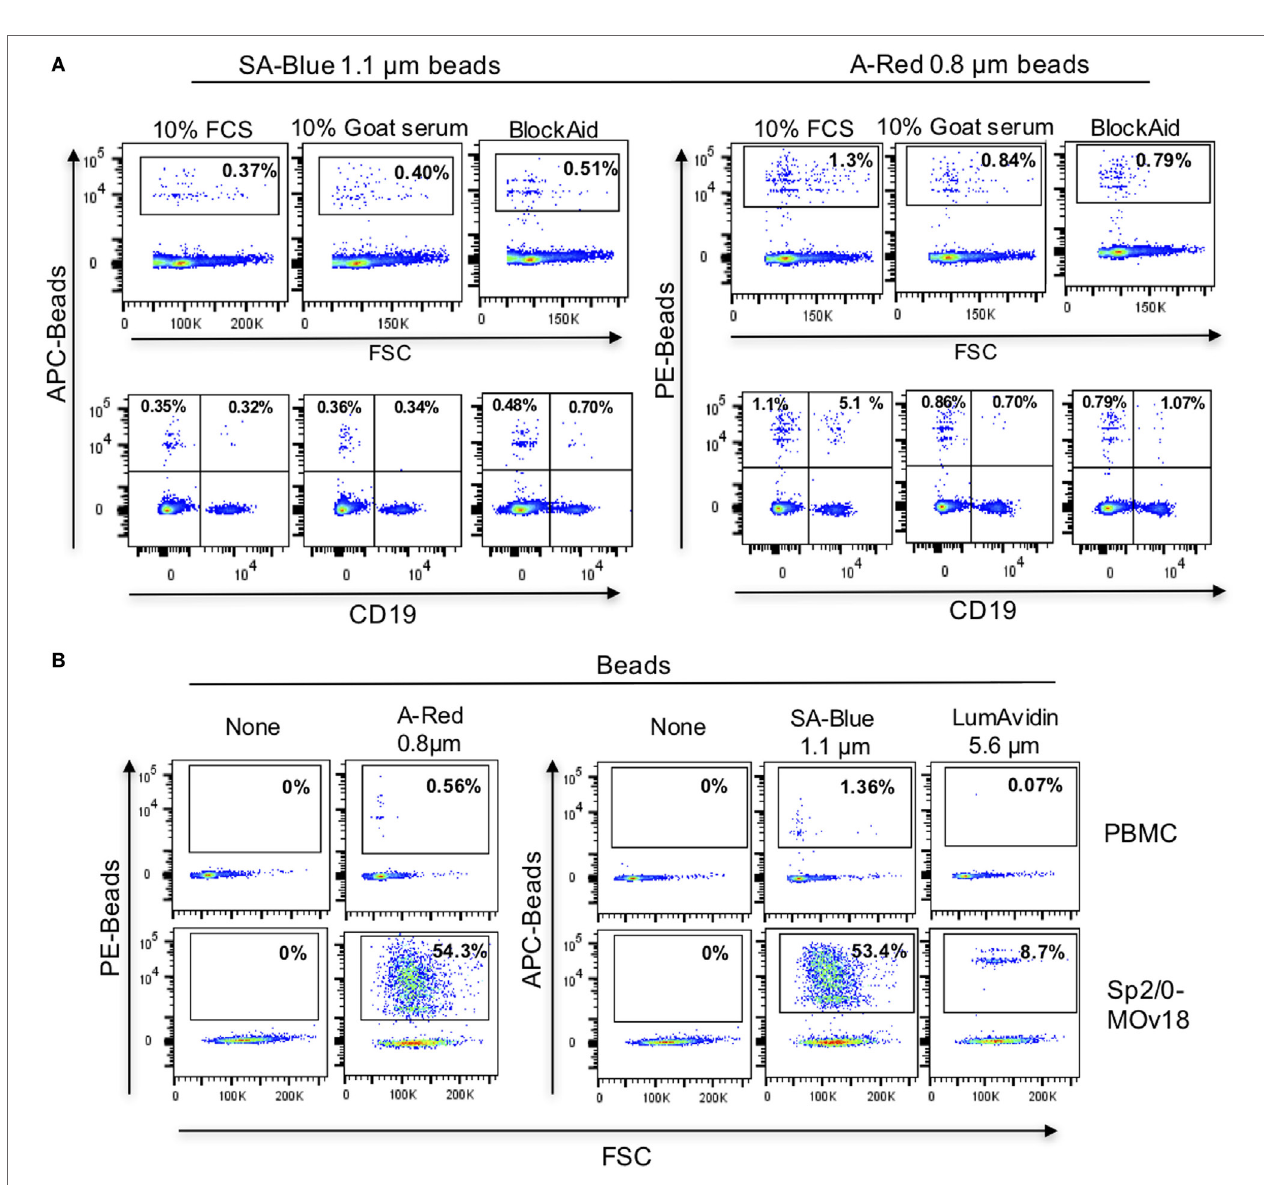
FigUre 5 | Background binding of fluorescent beads to human peripheral blood mononuclear cells (PBMC). (a) Flow cytometric analyses demonstrating the effects of blocking agents in reducing the background binding of the SA-Blue 1.1 µm and A-Red 0.8 µm beads to cells. Top panels: non-specific binding to total PBMC; Bottom panels: background among B cells. (B) Analyses of FR α -coated A-Red 0.8 µm, SA-Blue 1.1 µm, and LumAvidin 5.6 µm beads incubated with PBMCs (to establish the background staining of the beads), or with Sp2/0-MOv18 cells (to establish binding to antigen-reactive positive cells).